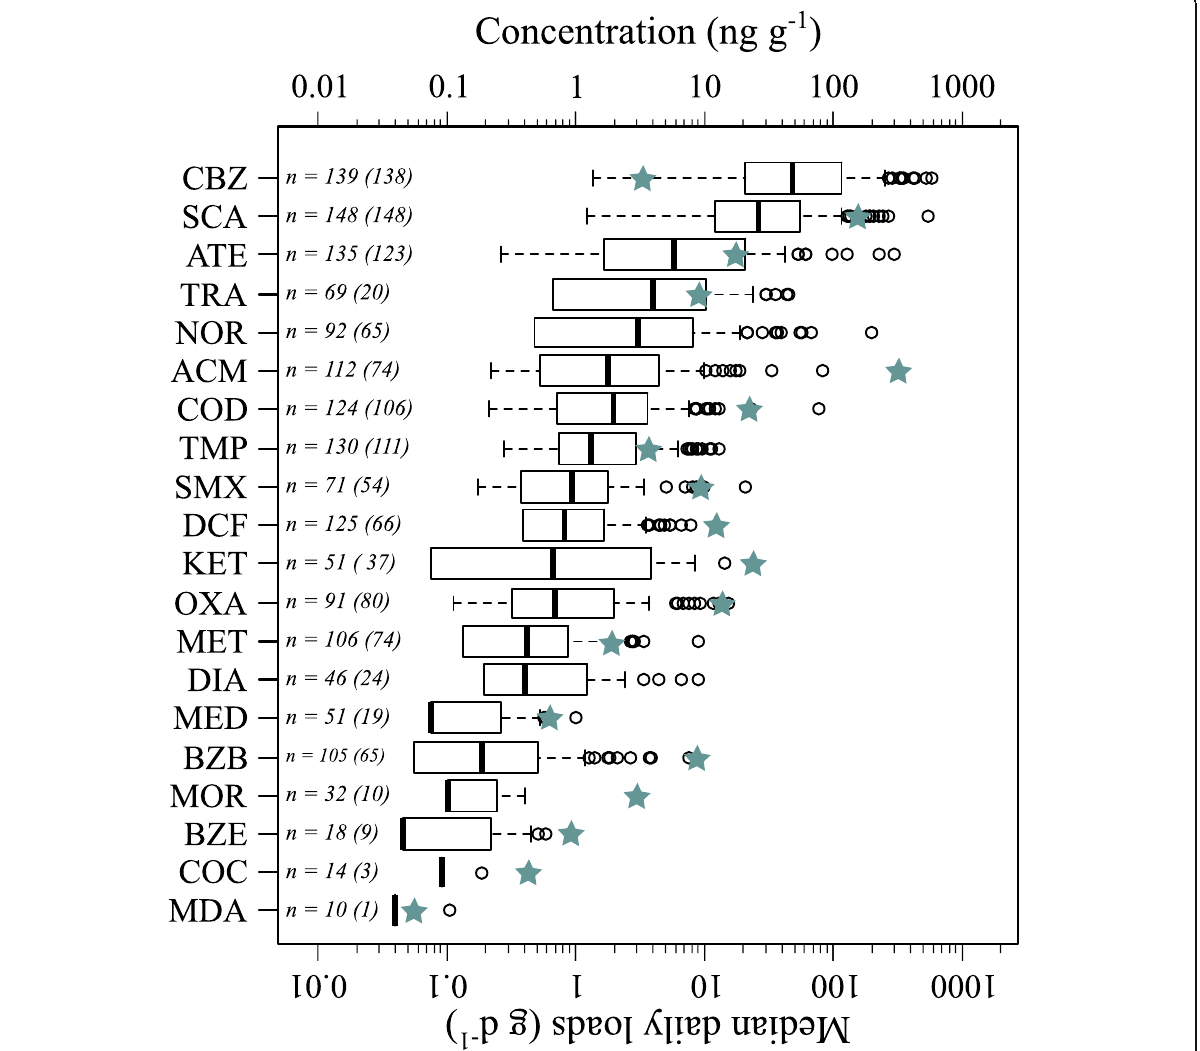
Fig. 2 The number of samples in which the DTR was detected (i.e. > LOD) is indicated in italics, and the number of samples in which the DTR was also quantified is indicated in brackets (i.e. > LOQ). Grey stars indicate the median daily load of each DTR in the wastewater influent of a WWTP in the same area during 84 consecutive days in Thiebault et al.